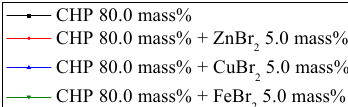
Figure 4. Heat flow versus temperature plot for 80.0 mass% CHP mixed with ZnBr 2 , CuBr 2 or FeBr 2 , tested using TAM III scanning analysis at 100.0 °C.